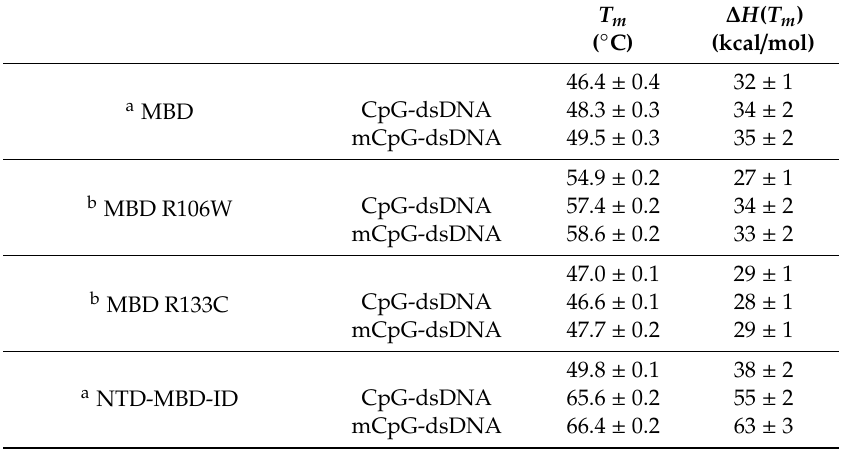
Table 3. Thermal stability of the di ff erent MeCP2 variants in the presence of unmethylated (CpG-) and methylated (mCpG-) dsDNA at pH 7 and high ionic strength (NaCl 150